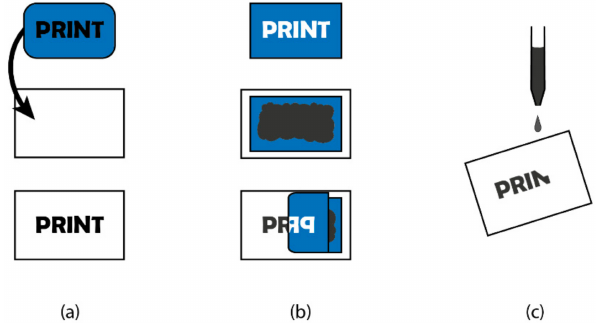
Figure 1. Illustration of the three printing techniques. ( a ) represents the positive contact printing similar to stamping, ( b ) represents the negative contact printing similar to screen printing, and ( c ) represents non-contact printing similar to inkjet printing, where ink is ejected from a